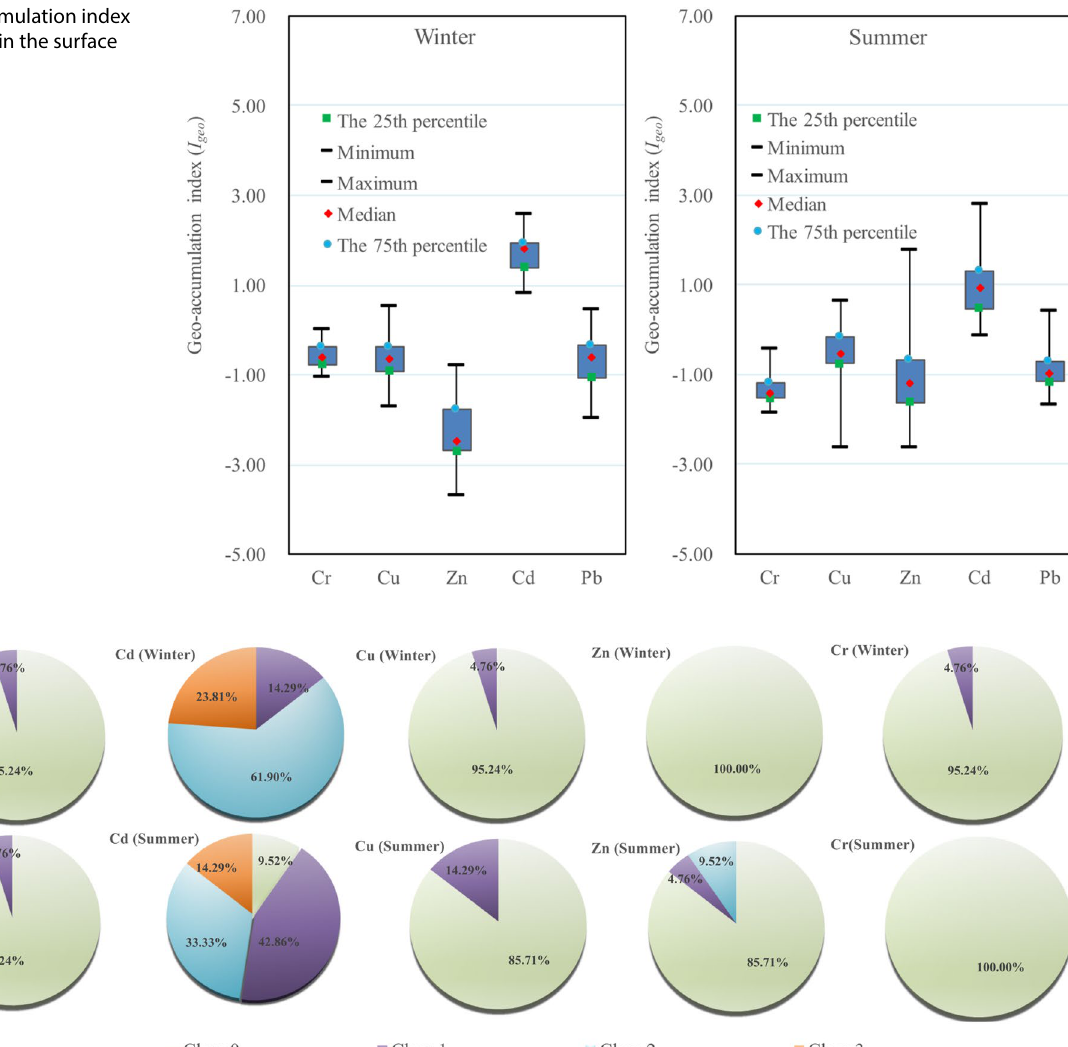
Fig. 3 Geo-accumulation index of heavy metals in the surface sediments